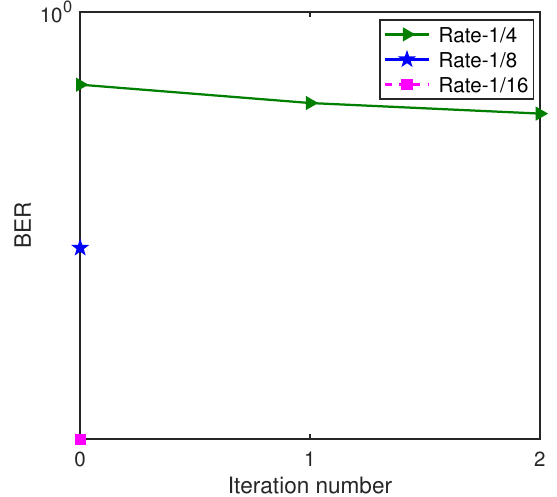
Figure 17. BER performance of the GL turbo system with S256 for Yellow Sea